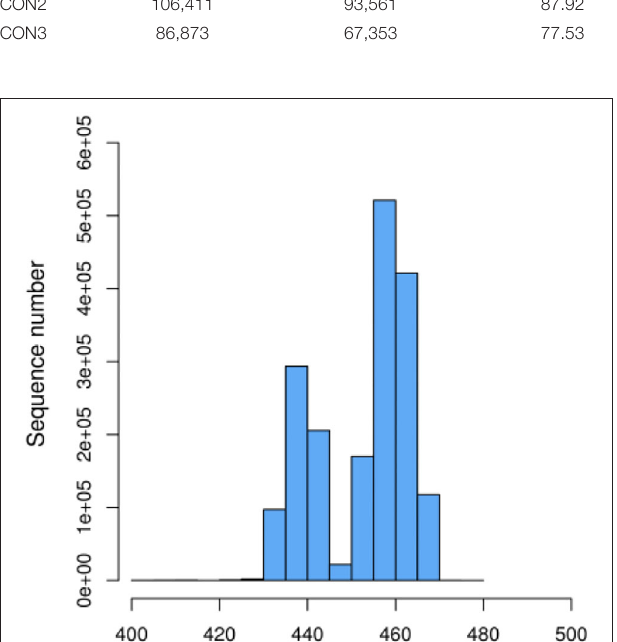
FIGURE 1 | Effective sequence length